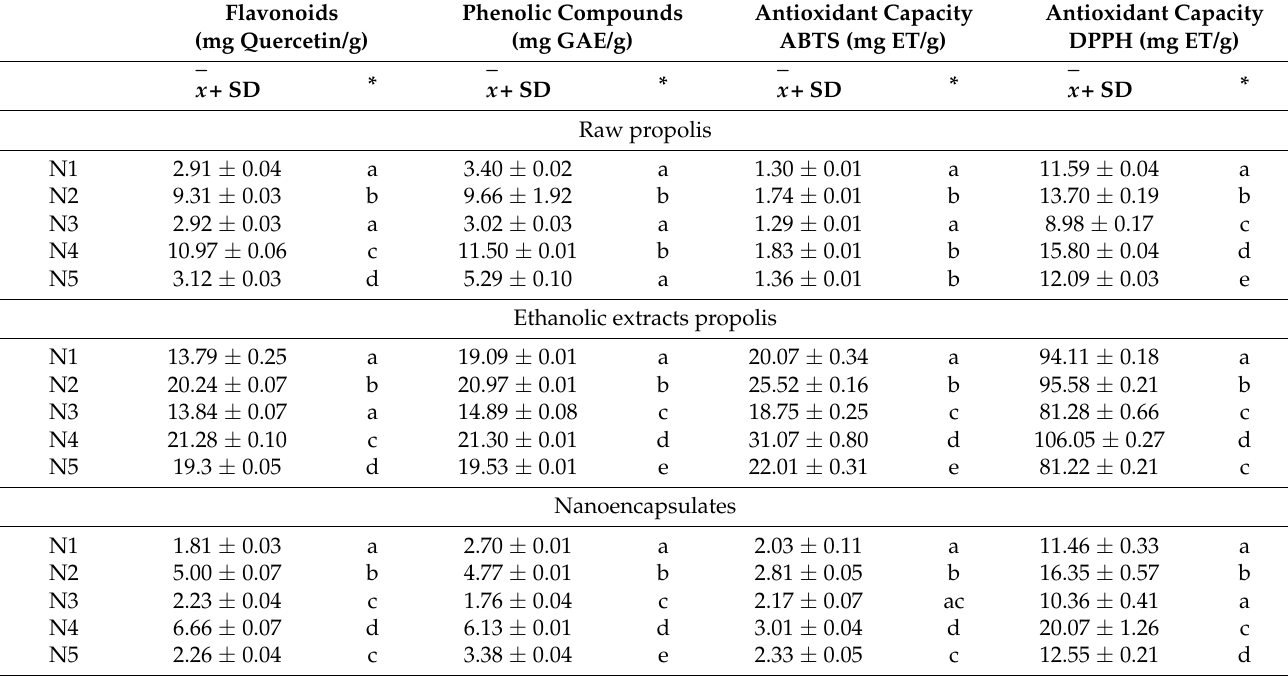
Table 1. Flavonoid content, phenolic compounds, and antioxidant capacity by DPPH and ABTS.